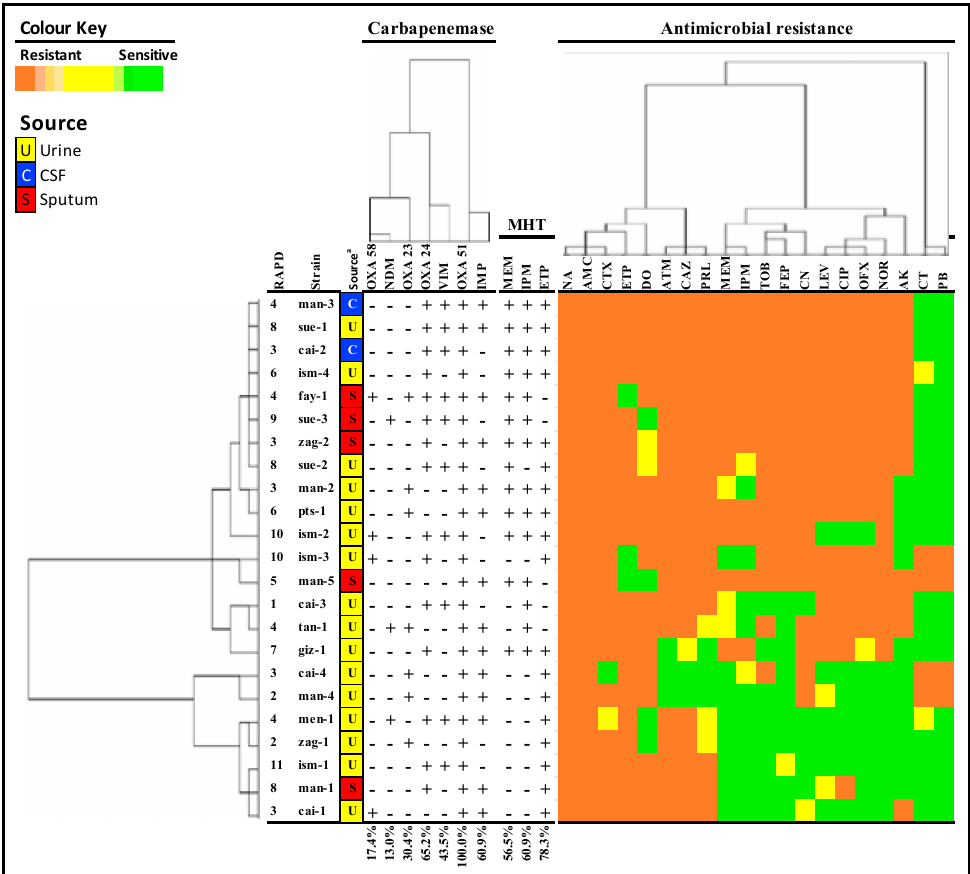
Figure 1. Random Amplification of Polymorphic DNA (RAPD) type, strain, source, carbapenemases, antimicrobial susceptibility, and MHT test of the 23 A. baumannii isolates. Individual isolates showing hierarchical clustering of isolates and factors. Binary factor (carbapenemase genes) indicated by presence (+) and absence (-); however, ordinal factor (antibiotics) indicating resistance by orange color, intermediate (yellow), and sensitive (green). Abbreviations: tobramycin (TOB), gentamycin (CN), amikacin (AK), norfloxacin (NOR), levofloxacin (LEV), ciprofloxacin (CIP), nalidixic acid (NA), ampicillin (AMP), piperacillin (PRL), amoxicillin/clavulanic acid (ATM), ceftazidime (CAZ), cefepime (FEP), cefotaxime (CTX), meropenem (MEM), imipenem (IPM), doripenem (DO), ertapenem (ETP), colistin (CT), and polymyxin B (PB). Table 3. Antimicrobial resistance profiles of A. baumannii